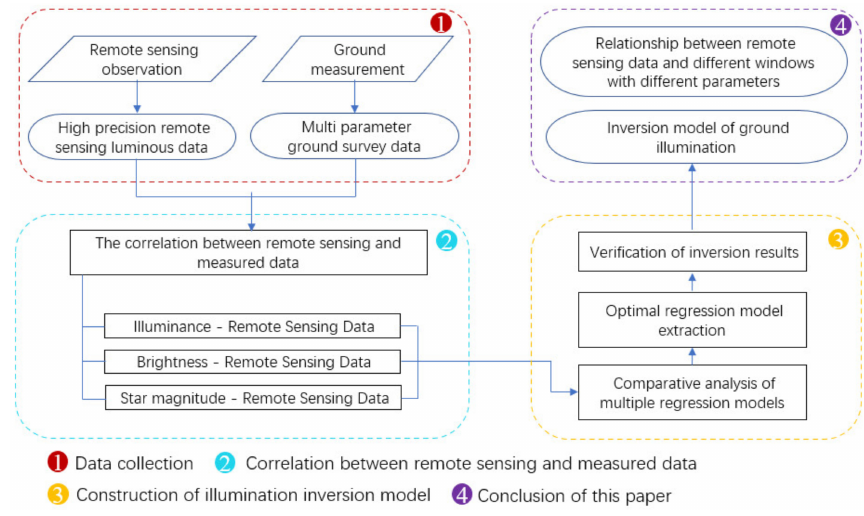
Figure 2. Technical route of this chapter.